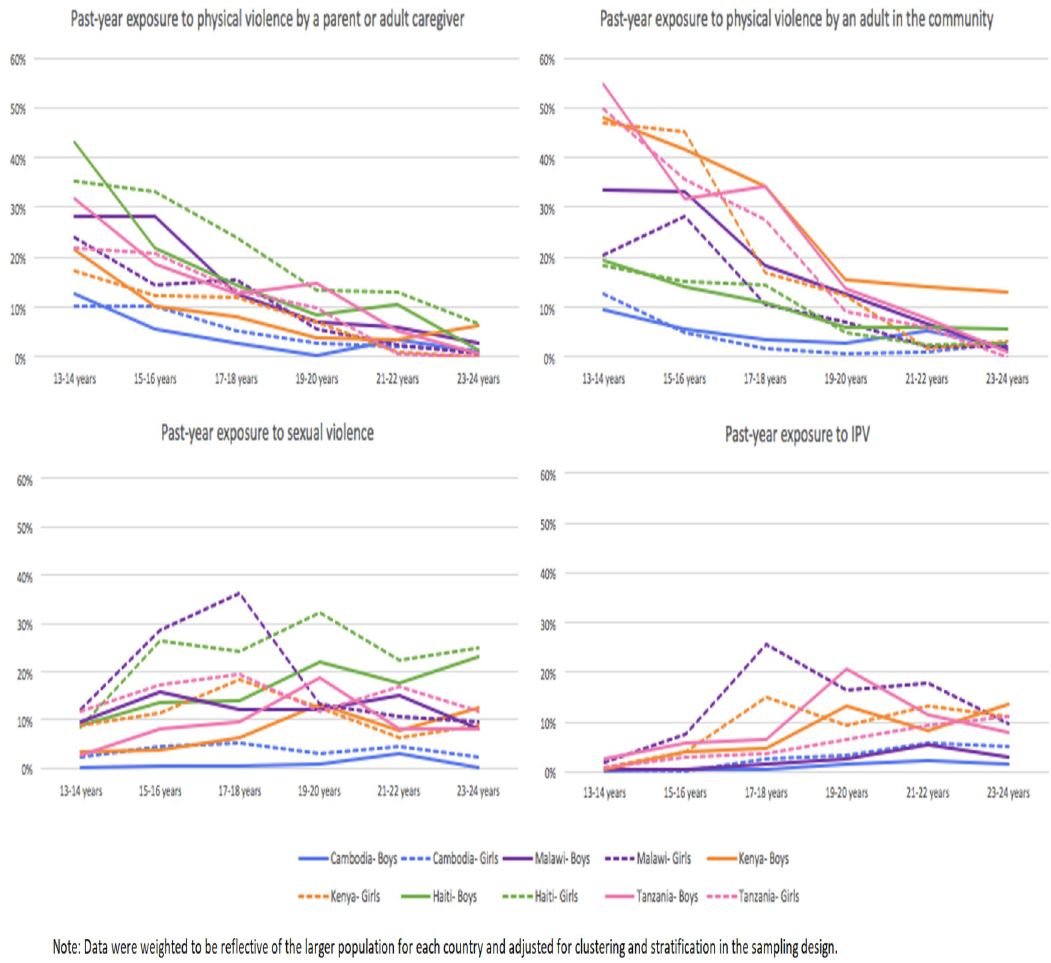
Fig 1. Physical and sexual violence experiences in the past year by age and gender in Cambodia, Haiti, Kenya, Malawi, and Nigeria.